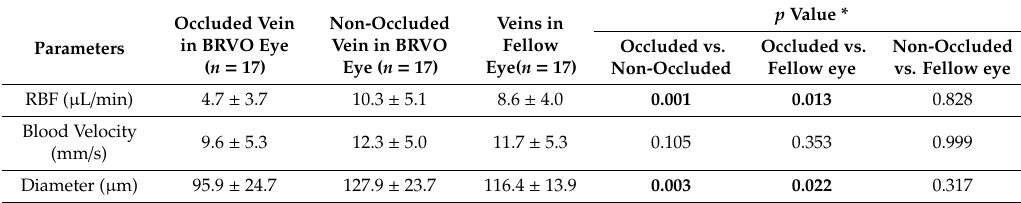
Table 2. Comparison of the retinal blood flow parameters between the BRVO (occluded and non-occluded) and the fellow eyes.